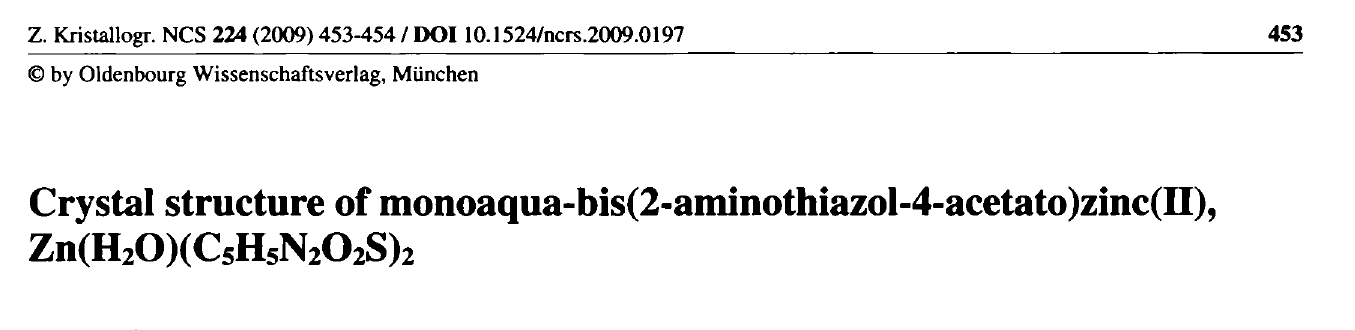
Zn atoms in the title crystal structure are five-coordinated. Zn links two thiazole units via Ν and O and one terminal water mole- cule via 03 forming a monomer. The Zn—O bonds are in the